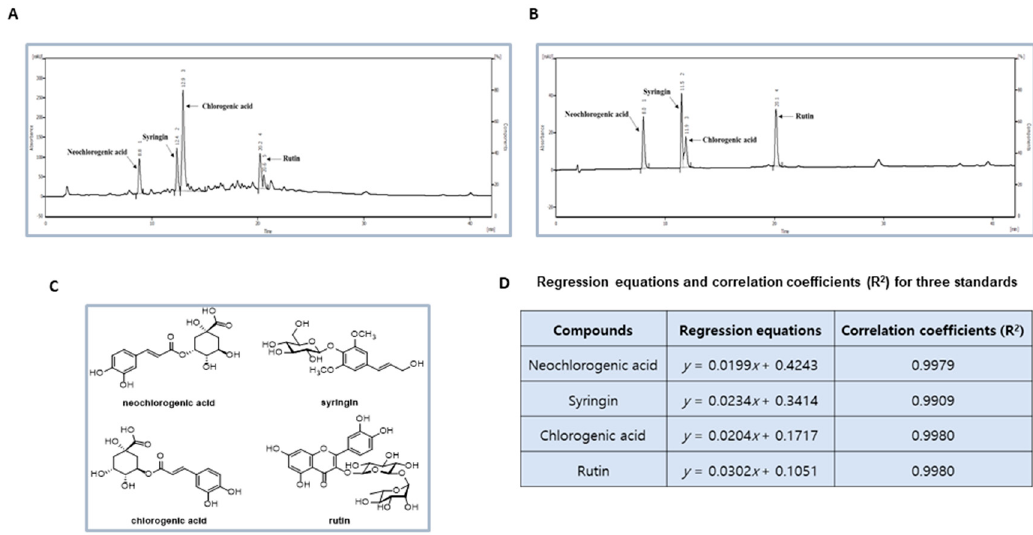
Figure 1. Preparation of Dendropanax morbifera water extract (DP) and experimental design for streptozotocin (STZ)-induced nephrotoxicity in rats. ( A ) High-performance liquid chromatography (HPLC)-UV chromatogram for DP extract. Major components in DP extract were identified and quantified by using HPLC analysis. HPLC analysis was carried out via gradient elution on a Phenomenex Kinetex C18 column (150 × 4.6 mm, 5 μ m). The flow rate, column oven temperature, and UV wavelength for detection were set at 1 mL/min, 30 °C, and 254 nm, respectively. ( B ) Representative chromatogram on standard compounds (neochlorogenic acid, syringin, chlorogenic acid, and rutin). ( C ) The chemical structures of major compounds in DP extract and the regression equations and correlation coefficients for the four standard compounds. ( D ) The regression equation and correlation coefficient (R 2 ) for three standards.